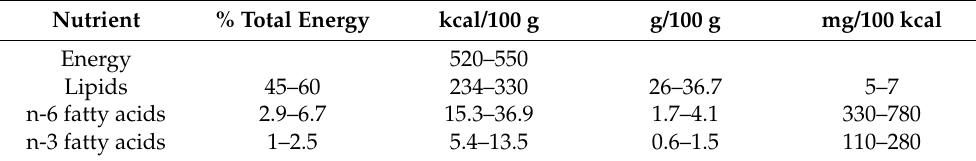
Table 1. Ready-to-use therapeutic foods fatty acid composition guidelines a